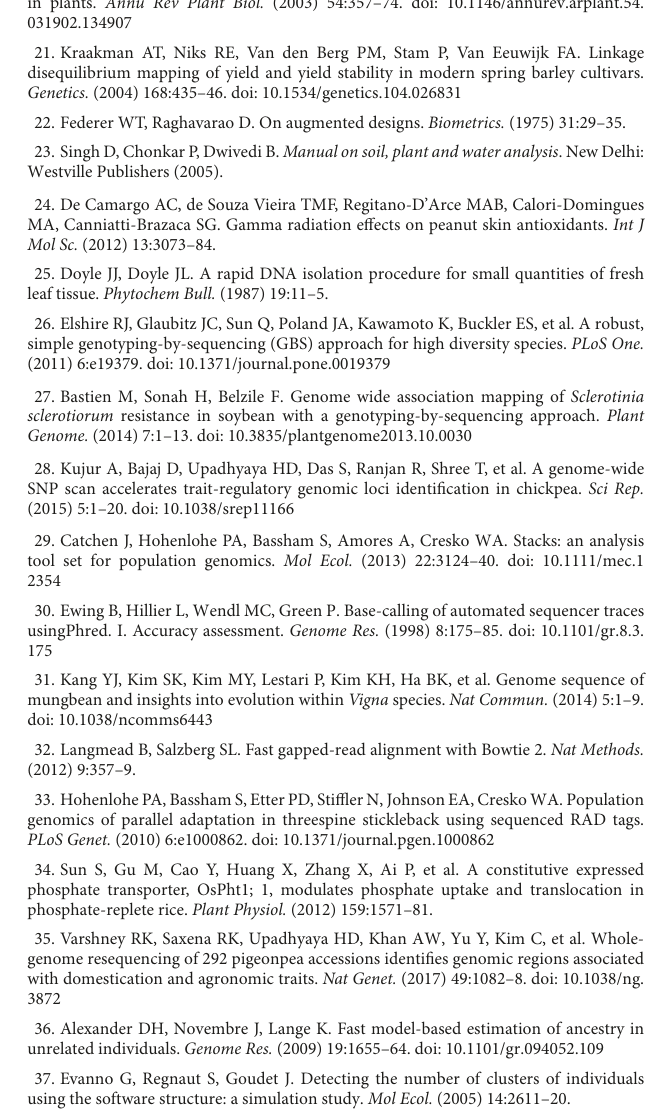
SUPPLEMENTARYFIGURE3 Circular diagram depicting a summarized view of the significant association of SNP markers with all the four traits in the study along with SNP density in the outer